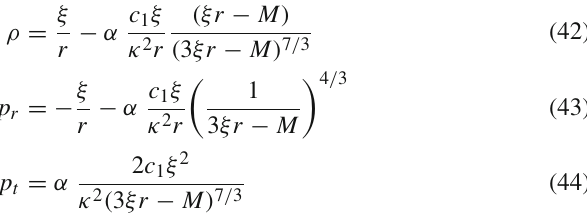
Fig. 2 Fluid parameters ρ, p r , p t versus radial coordinate r for the particular constraint # 2. Left panel: Energy density ˜ ρ vs radial coor- dinate r for different values of the parameter α . Middle panel: Radial pressure p r vs radial coordinate r for different values of the parameter